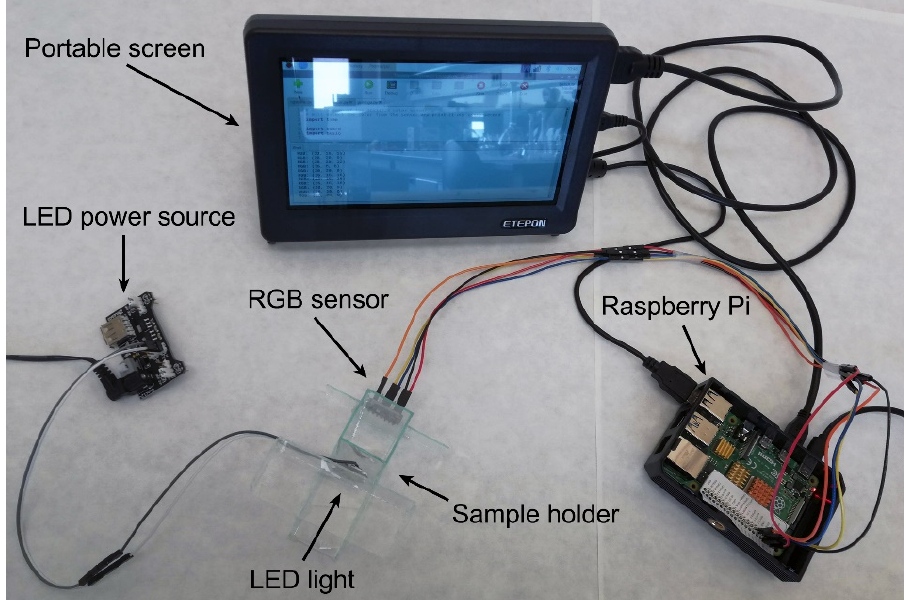
Figure 1. Example of setup: RGB sensor and external LED light mounted on a glass sample holder (bottom center), portable screen for script and output visualization (top center), Raspberry Pi (right), and external LED light power source (left).